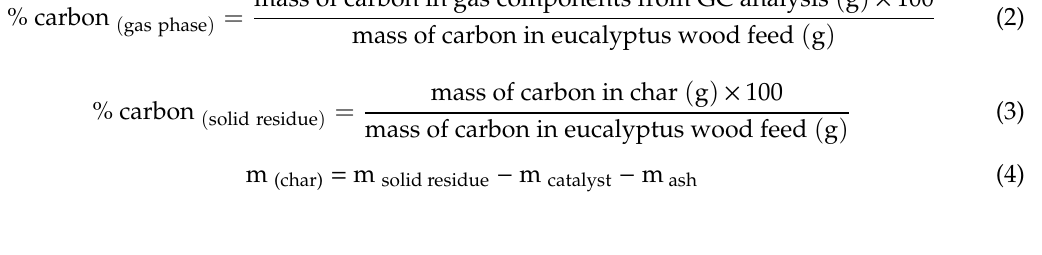
Figure 1. Schematic diagram of batch reactor assembly.